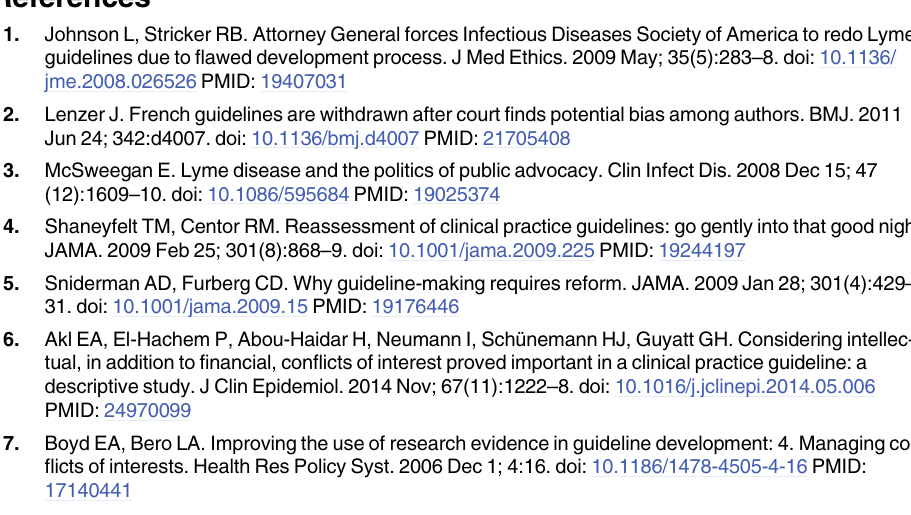
S1 Table. Search strategy for evidence inventory of surveys of guideline developer organi- sations. S2 Table. List of 92 guideline developer